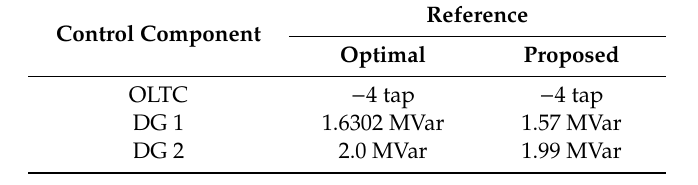
Table 6. Simulation results of the tap position and reactive power for CVR in case 2.